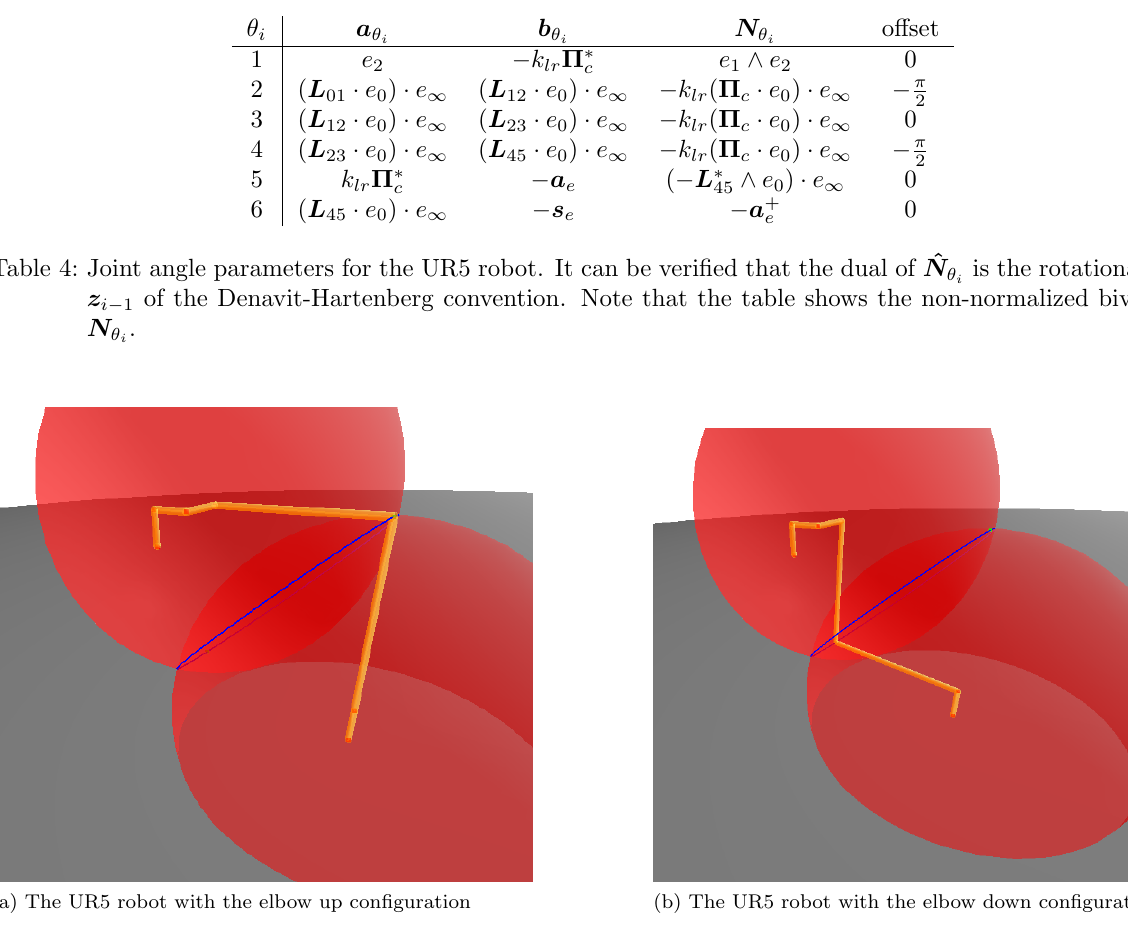
Figure 10: The two red spheres are S 1 and S 3 , the blue circle is C 2 and the green point pair is Q 2